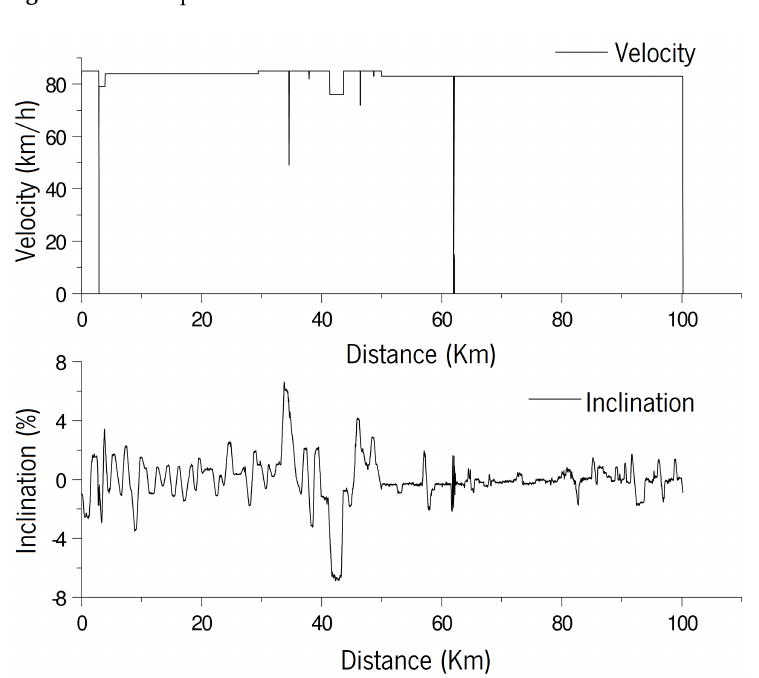
Figure 4. WHVC parameters.